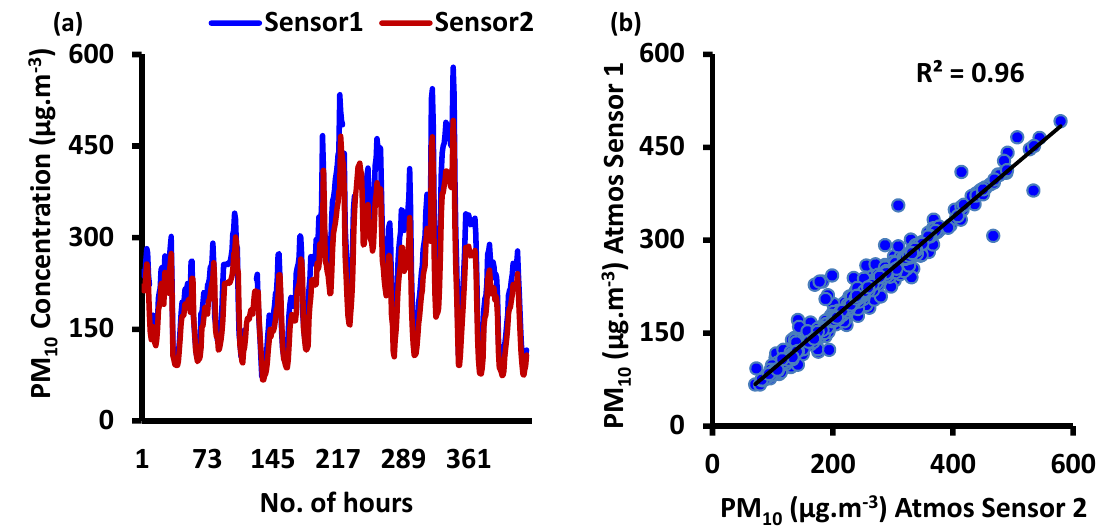
Figure 3. ( a ) Time-series of ambient PM 10 concentrations ( µ g · m − 3 ) from two co-located Atmos PM sensors for consistency test and ( b ) scatterplot for the collected data from two co-located sensors at ambient conditions.